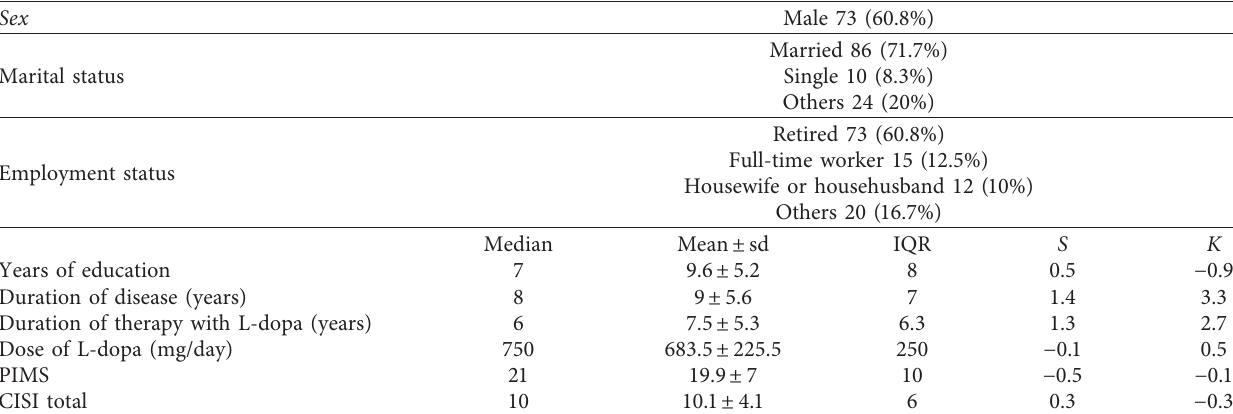
Table 3: Descriptive statistics of the sample ( N � 120).